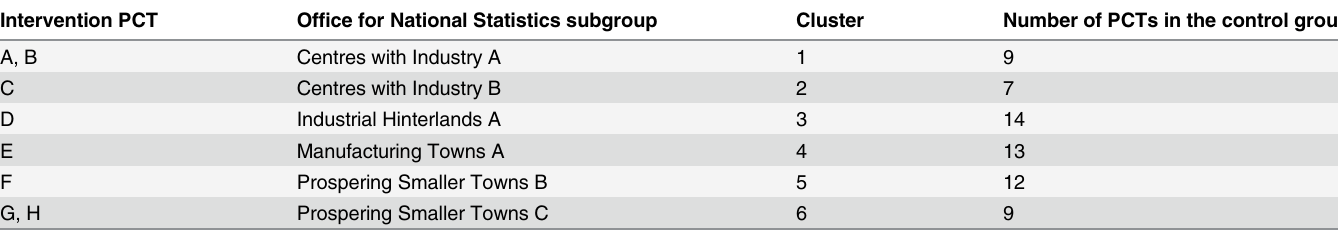
Table 1. Intervention PCTs, ONS subgroups, clusters and number of control PCTs Intervention